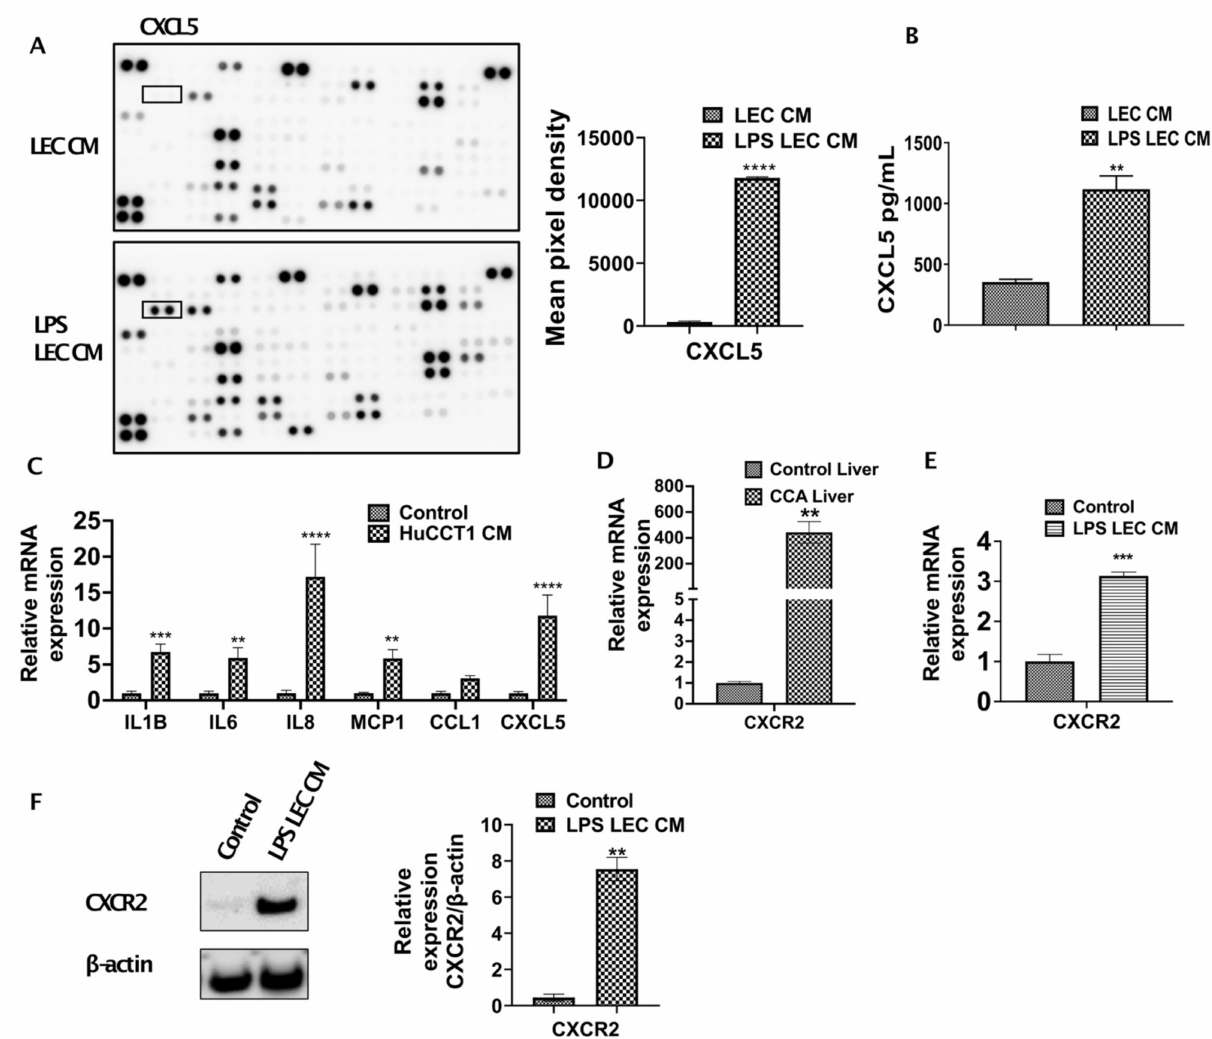
Figure 2. Inflamed LECs express high levels of CXCL5 and induce upregulation of CXCR2 expression in CCA cells. ( A ) Cytokines present in conditioned medium (CM) of LECs primed with LPS for 24 h were analyzed using human cytokine array kit (left panel) and the cytokine, CXCL5 (right panel) was quantified by densitometric analysis of the spots using ImageJ. Values are plotted as mean pixel density and represented as mean ± SEM, n ≥ 3; **** p ≤ 0.0001 represents value versus LEC CM ( B ) CXCL5 levels in LEC and LPS-LEC-CM were quantified by ELISA. ** p ≤ 0.01 value versus control ( C ) LECs were treated with CCA-CM for 24 h and the expression of inflammatory cytokine/chemokines including CXCL5 were measured by qPCR. Values are represented as mean ± SEM, n ≥ 3. ** p ≤ 0.01, *** p ≤ 0.001 and **** p ≤ 0.0001 value versus control (5% EGM). Expression of CXCR2 was measured by qPCR in ( D ) livers of control and orthotopic CCA tumor mice, ** p ≤ 0.01 value versus control liver and ( E ) CCA cells treated with LPS-LEC-CM. Values are represented as mean ± SEM, n ≥ 3. **** p ≤ 0.0001 value versus control (5% EGM). ( F ) CCA cells were treated with LPS LEC CM and the protein level expression of CXCR2 was measured by Western blot. Values are represented as mean ± SEM, n ≥ 3, ** p ≤ 0.01 value versus